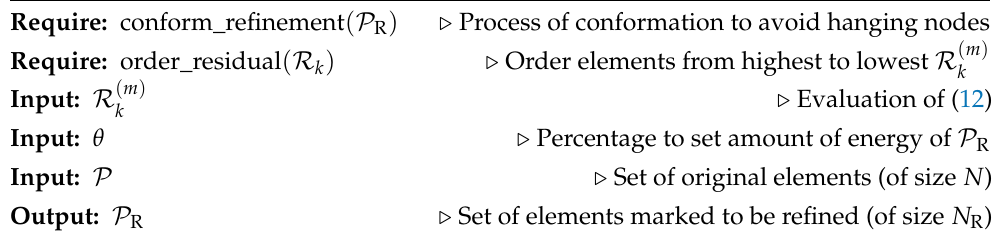
Algorithm 4 Fixed-energy fraction marking strategy